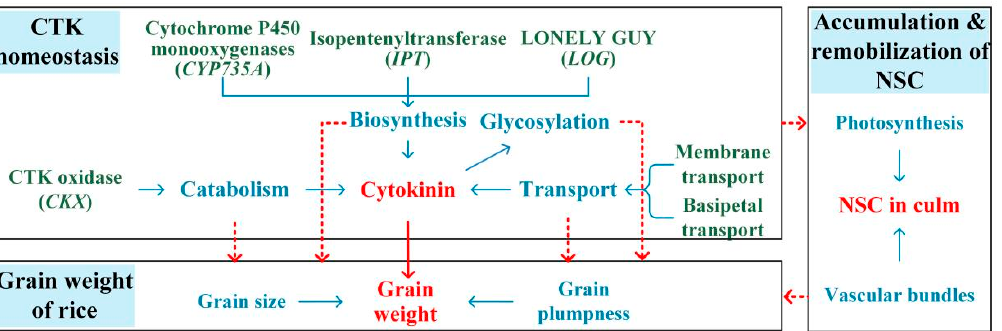
Figure 3. Proposed mechanisms underlying grain weight changes mediated by CTK under heat during the panicle initiation stage.